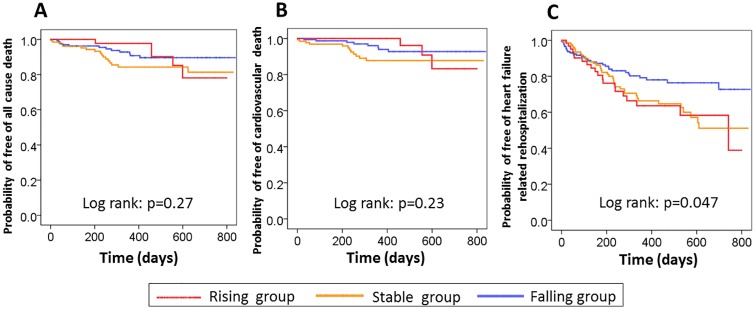
Comparison of Kaplan—Meier estimates for probability of (A) free of all cause death, (B) free of cardiovascular death, and (C) free of heart failure-related rehospitalization among the falling, stable, and rising groups.All cause death and cardiovascular death were not different among the falling, stable, and rising groups (Fig 2A, B). HF-related rehospitalization was significantly lower in falling group (p = 0.047; log-rank test; Fig 2C).